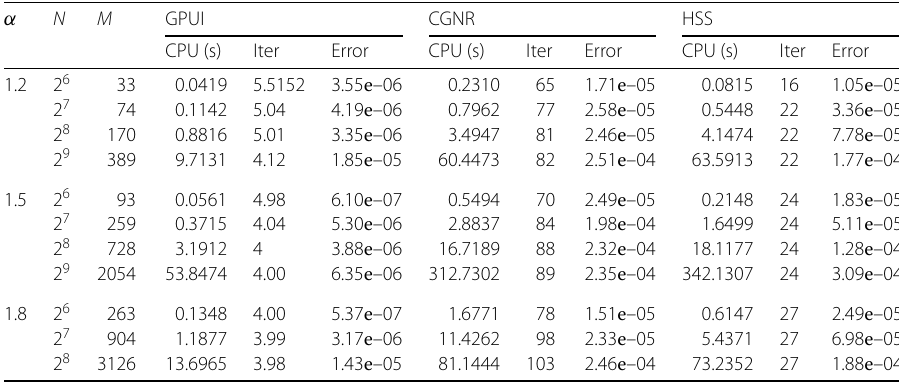
Table 3 Comparing results to solve Example 2 by the GPIU algorithm with ω = 1, δ = 0.99 and s = 0.01, and the CGNR method for α = 1.2, 1.5 and 1.8 α N M GPUI CGNR